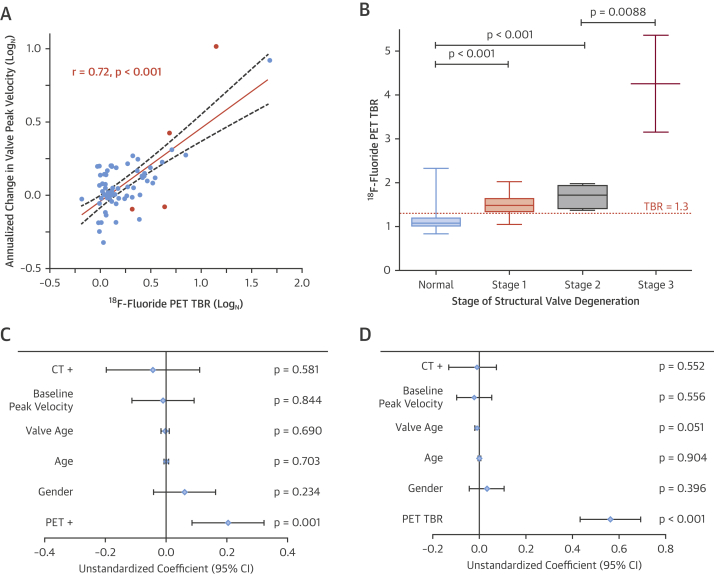
Baseline 18F-fluoride PET Uptake Predicts Subsequent Deterioration in Bioprosthetic Valve Function After 2 Years(A) A strong correlation was observed between baseline 18F-fluoride uptake in the bioprosthetic valves (TBR) and subsequent progression in bioprosthetic valve peak velocity (log transformation applied; r = 0.72; p < 0.001). Orange dots signify patients who developed new bioprosthetic valve regurgitation during follow-up. (B) 18F-fluoride uptake (dashed orange line represents threshold for increased 18F-fluoride uptake; TBR 1.3) in patients with different stages of structural valve degeneration after 2-year follow-up (stage 0: no significant change from post-implantation [n = 54]; stage 1: morphological abnormalities without significant hemodynamic changes [n = 9]; stage 2: new moderate stenosis and/or regurgitation [n = 5]; stage 3: new severe stenosis and/or severe regurgitation [n = 2]) (18) demonstrating incrementally higher uptake values with increasing severity of structural valve degeneration. (C and D) Forest plots of unstandardized coefficients (95% confidence intervals) from a multivariable linear regression analysis predicting change in bioprosthetic valve function (annualized change in peak velocity) during follow-up. When examining all relevant baseline characteristics, 18F-fluoride uptake was the only independent predictor of hemodynamic deterioration in valve function when used both as a dichotomous variable (PET+, TBR >1.3) (C) and as a continuous variable (TBR) (D). CI = confidence interval; other abbreviations as in Figures 1 and 2.